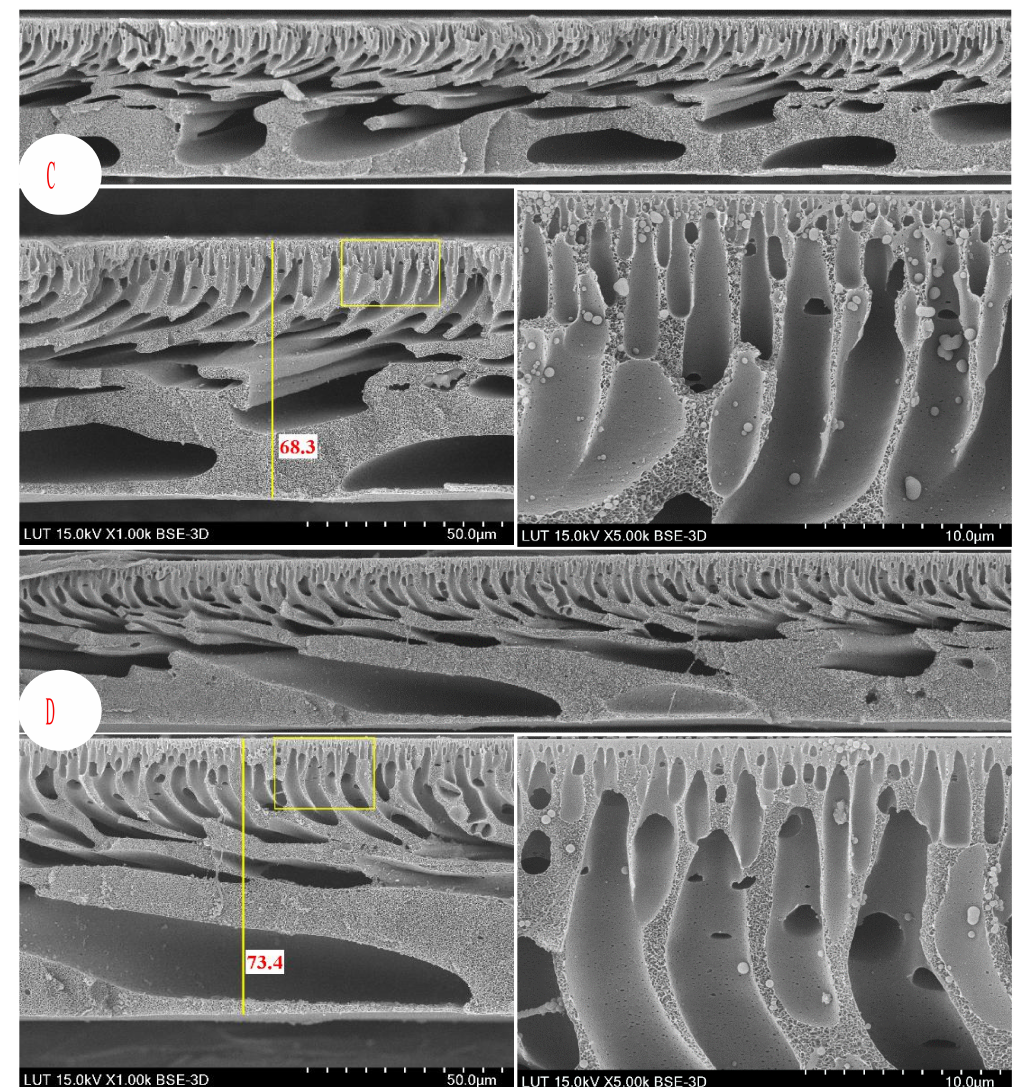
Figure 5. SEM cross-sectional images showing the effect of different amounts of added DES-lignin; ( A ) 0 wt %, ( B ) 0.25 wt %, ( C ) 0.5 wt %, ( D ) 1 wt %. The cross sections are on the left and the zoom sections of marked top layers are shown on the